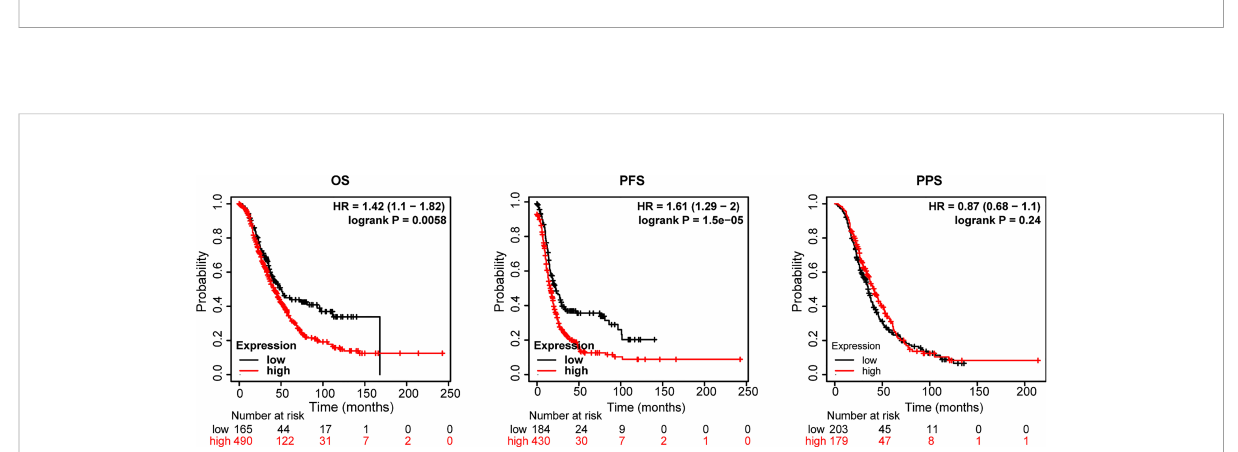
FIGURE 5 Relationship between the STATs family and survival of ovarian cancer patients. Probe Id (Gene symbol): 200887_s_at (ISGF-3, STAT91, STAT1), 225636_at (STAT2), 225289_at (STAT3), 206118_at (STAT4), 203010_at (STAT5, MGF, STAT5A), 212549_at (STAT5B), 201331_s_at (STAT6, IL-4- STAT, D12S1644). OS, overall survival; PFS, progression-free survival; PPS, post-progression survival, HR= hazard